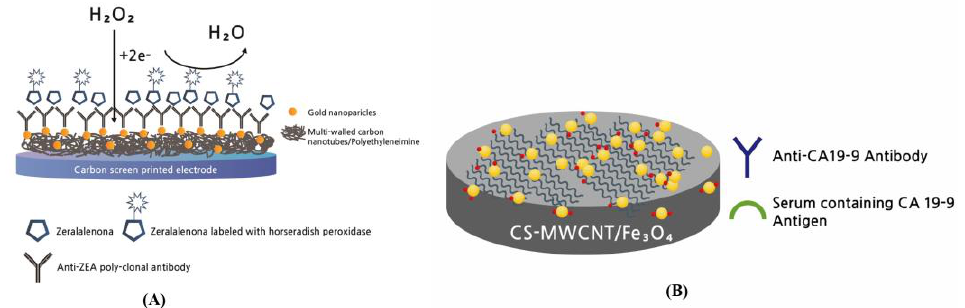
Figure 6. CNT-based biosensor with antibody as a bioreceptor. ( A ) Scheme of an electrochemical immunosensor to determine zearalenone (ZEA) mycotoxin [85]; ( B ) Scheme of bio-nanocomposite- based highly sensitive and label-free electrochemical immunosensor using Anti-AbsCA19-9/CS- MWCNT-Fe 3 O 4 immune-electrode fabricated on glassy carbon electrode (GCE) for the detection of carbohydrate antigen 19 – 9 (CA19-9) [86].